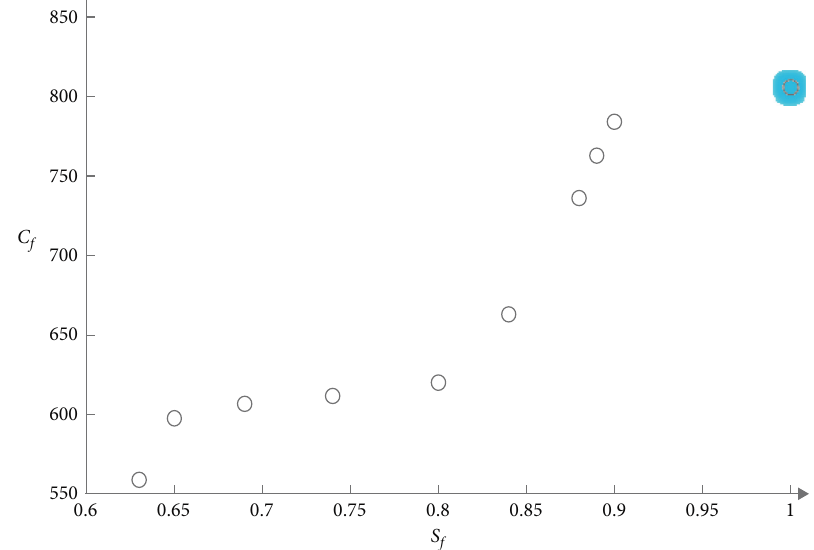
Figure 7: Noninferior solution set of example RC105.